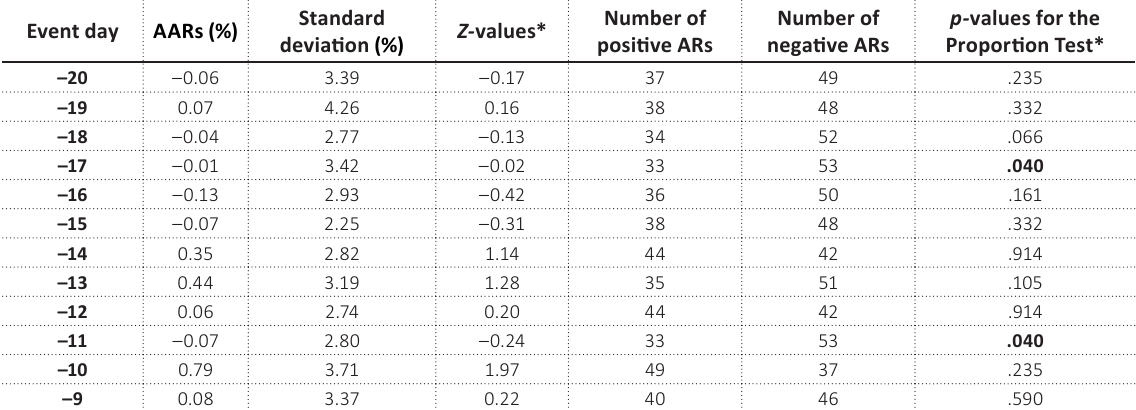
Table 4. AARs and Z -values – Announcement Day (split ratio